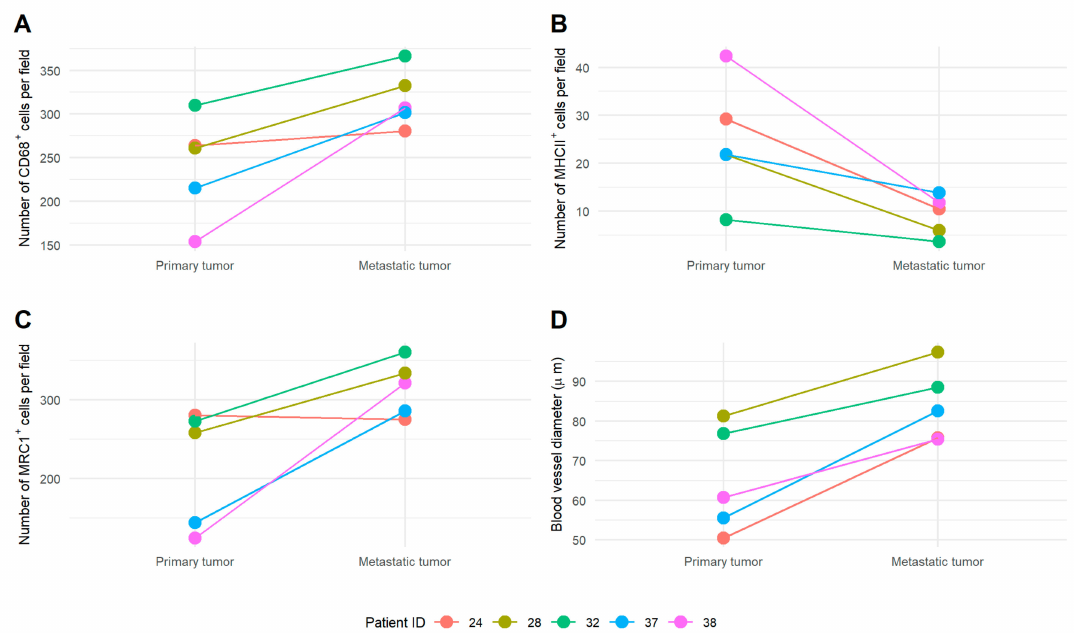
Figure 1. Comparison of macrophage profile and blood vessel diameter in matched biopsies at primary and metastatic tumor sites. The amount of ( A ) cluster of di ff erentiation (CD) 68 + , ( B ) major histocompatibility complex (MHC) II + , and ( C ) anti-mannose receptor C type 1 (MRC1) + cells for five patients with matched biopsies, and ( D ) blood vessel diameter ( µ m) based on glucose transporter-1 (Glut1) expression. Samples of patients 37 and 38 were collected at primary debulking surgery (PDS), while samples of patients 24, 28, and 32 were collected at interval debulking surgery (IDS).